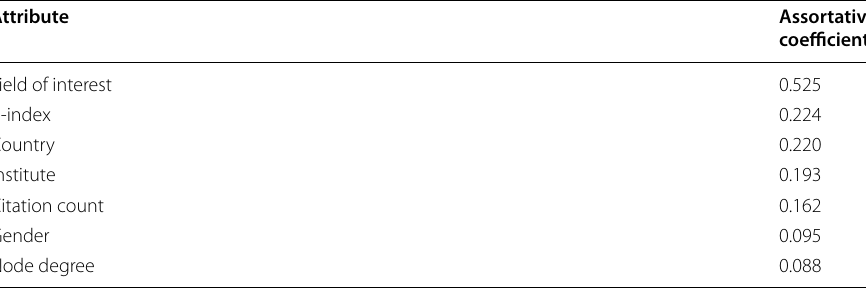
Table 3 Assortativity coefficients for different attributes in the MACN